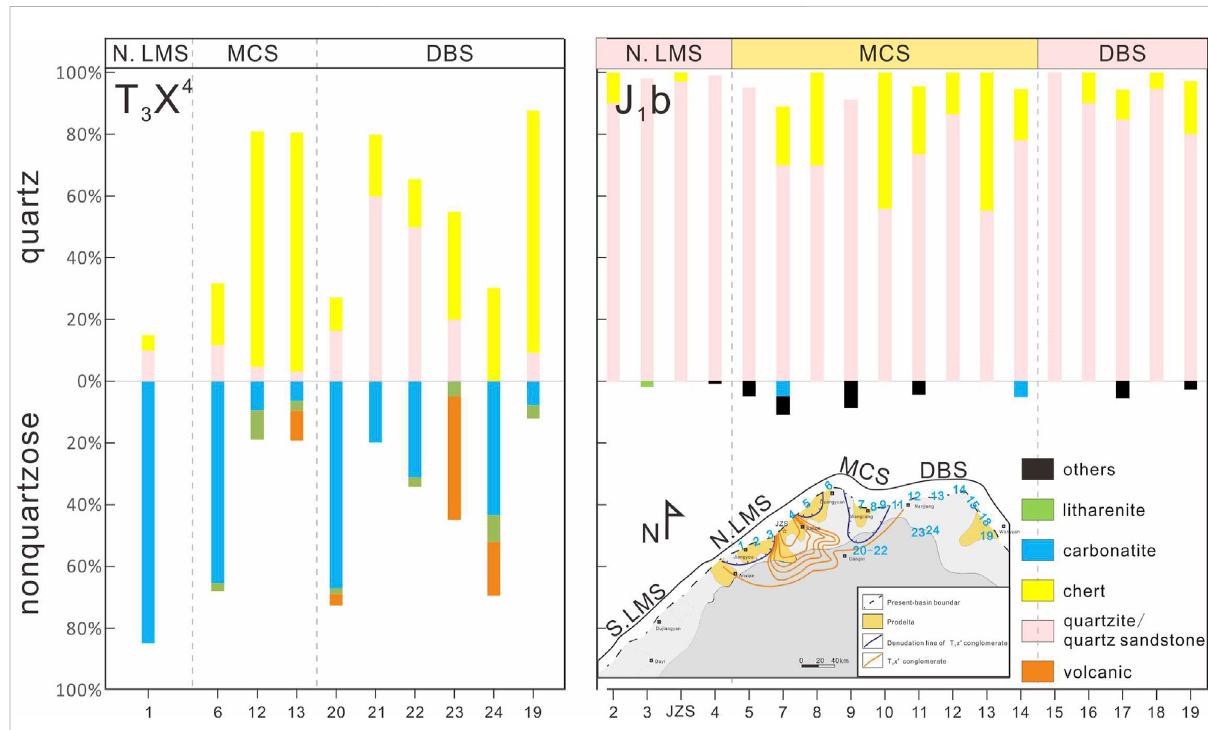
FIGURE 6 Comparison of conglomerate compositions between the Upper Triassic Xujiahe Formation and the Lower Jurassic Baitianba Formation in the NWSichuan Basin.JZS-Jinzishan,1-JiangyouQinglingkou,2- Jiangyou Daliangshang, 3-Jiangyou Erlangmiao,4-Baitianba, 5- Guangyuan